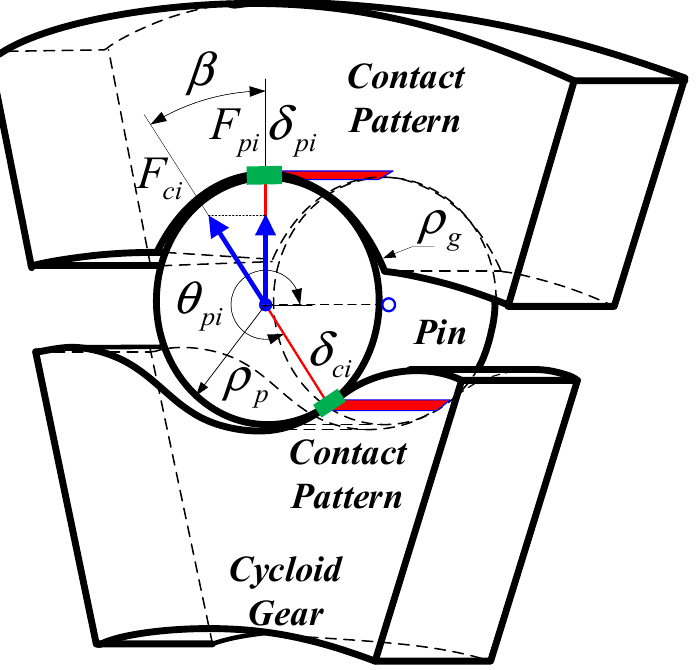
Figure 7. Hertzian contact stiffness mechanics model of the cycloid-pin gear pair.